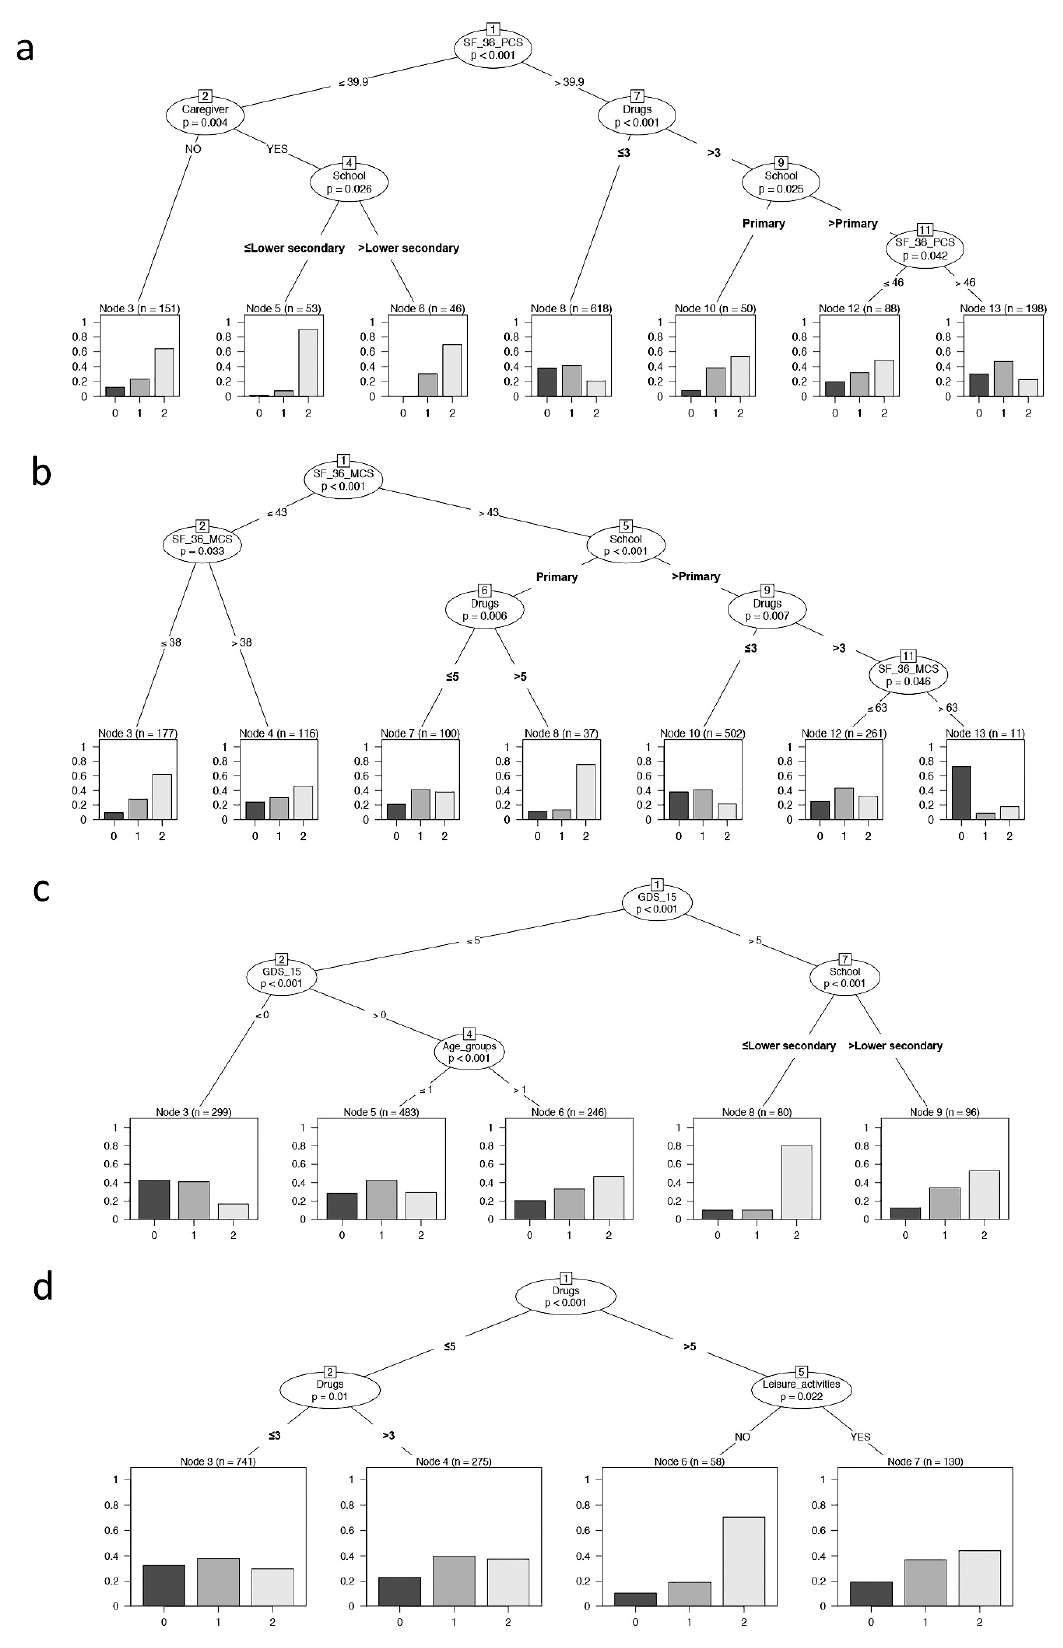
Figure 3. Binary tree computed by conditional recursive partitioning by psychological